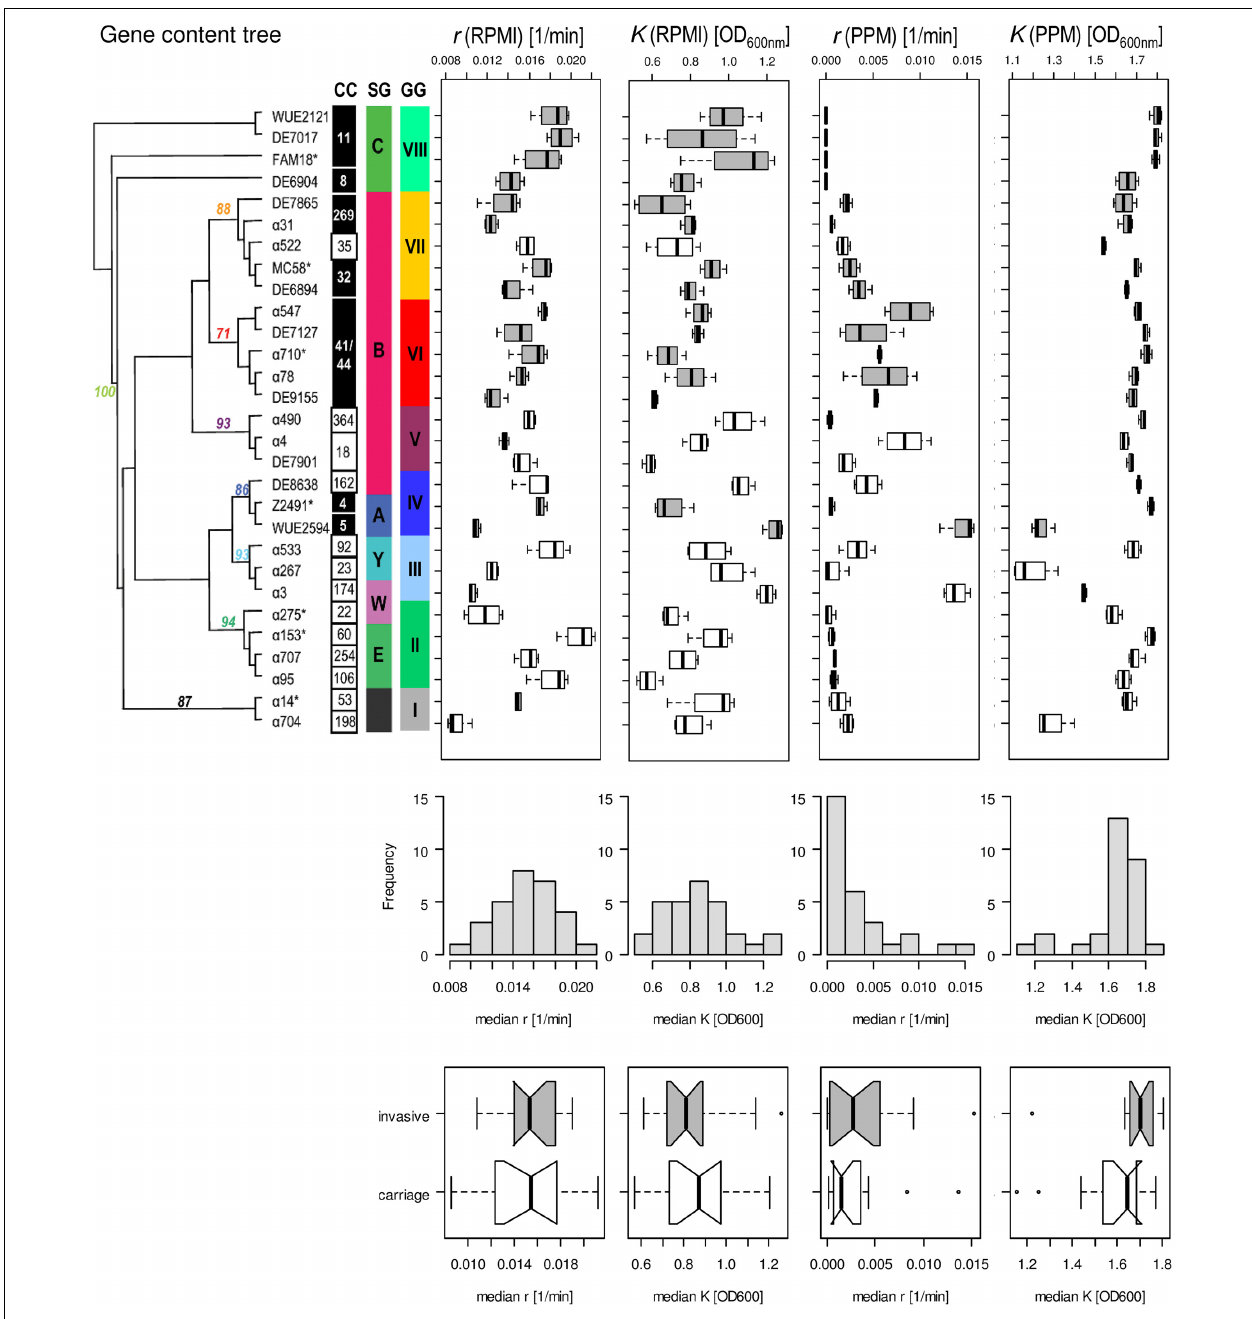
FIGURE 4 | Comparison of the fitted growth parameters for 29 strains from 20 clonal complexes. On the left in the upper panel, a maximum parsimony tree taken from Joseph et al. (2011) is shown with bootstrap values at nodes for grouping of the strains based on gene content. Strains with an asterisk right to their name have been used for computational analyses of intragenic recombination and pathway mapping as depicted in Figure 1 . The clonal complexes (CC), serogroups (SG) and genome groups (GG) for each strain are given next to each strain. Consecutively and from left to right, box-and-whiskers-plots summarize for each strain the estimated growth rates and capacities in RPMI and PPM medium, respectively. The boxes indicate the upper and lower quartiles, respectively, and the lines in the